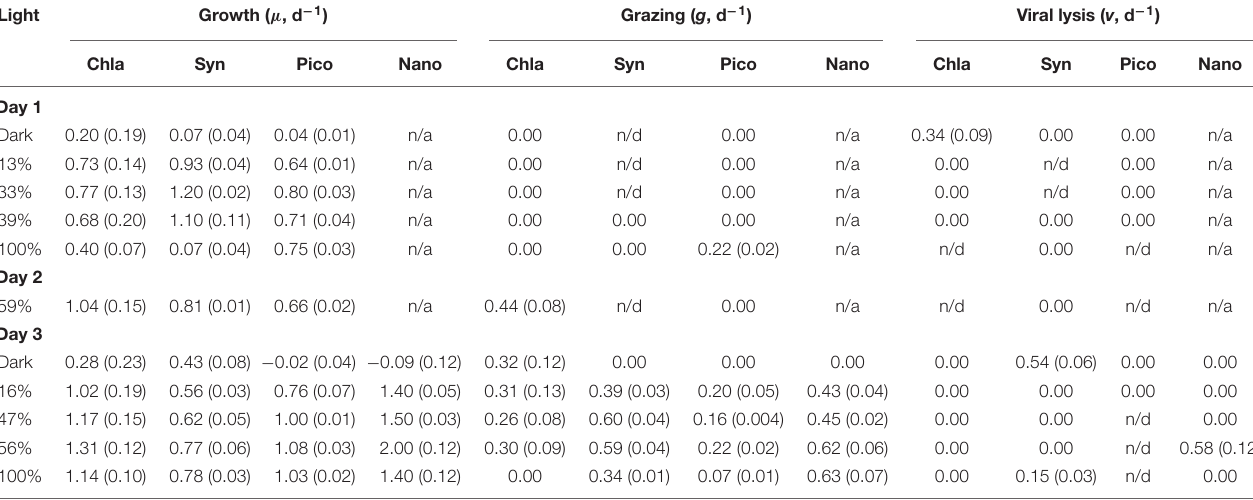
TABLE 1 | Daily rates (d − 1 ) of phytoplankton growth ( µ ), and grazer- ( g ) and virus-induced ( v ) mortality for three consecutive days at station 4 during NAAMES II.